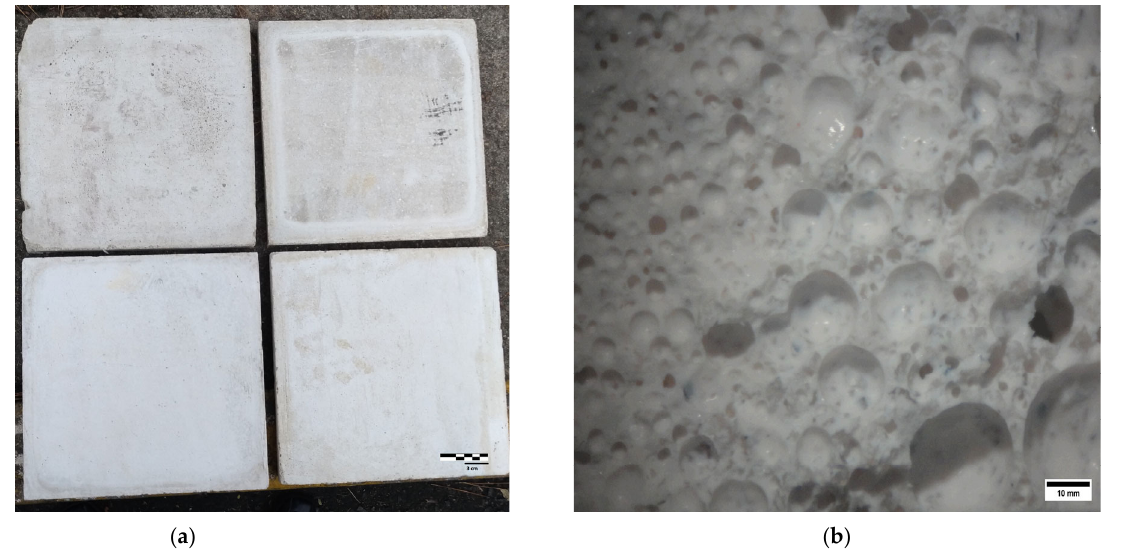
Figure 7. Geopolymer mortar panels used in the thermal conductivity test 30 × 30 × 3 cm³ ( a ), and image of geopolymer mortar with 0.8% H 2 O 2 made with binocular stereomicroscope ( b ). Table 3. Thermal conductivity and thermal transmi tt ance used for the mortars.